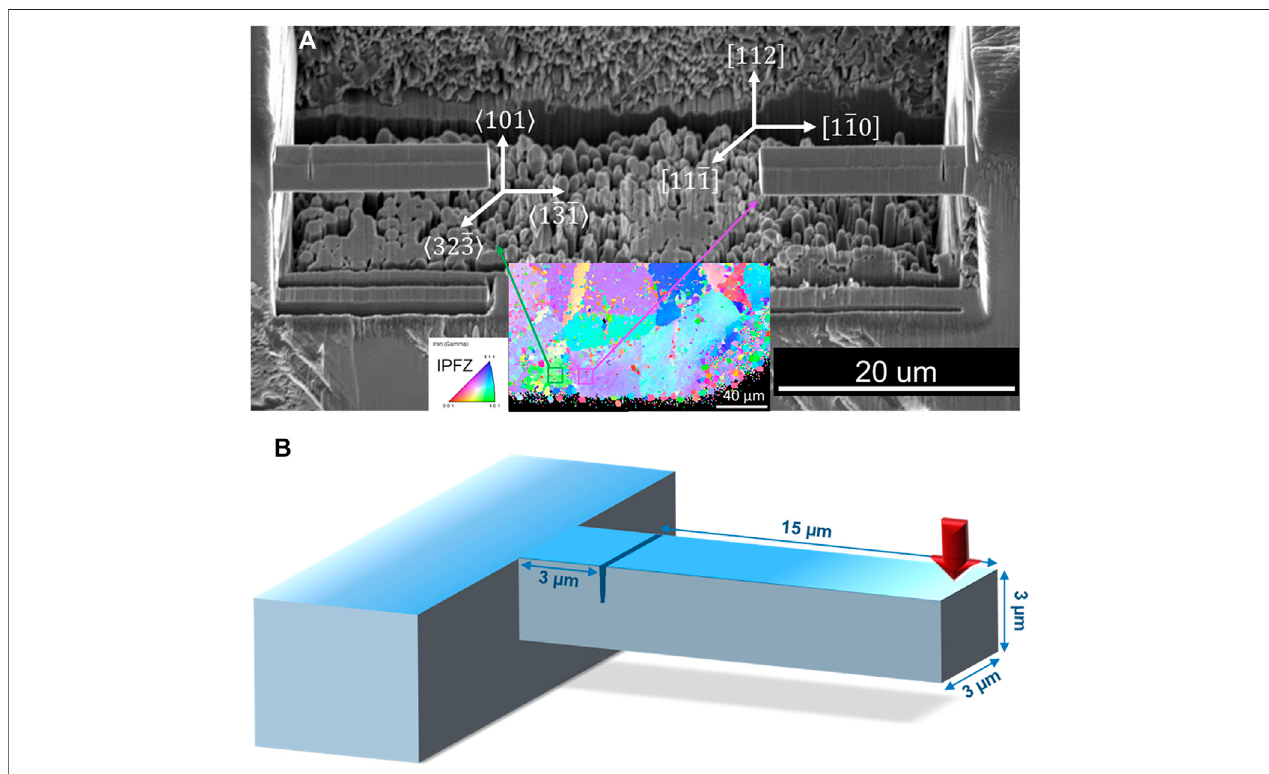
FIGURE 1 | (A) Fabricated microcantilevers in the archive material. The left cantilever is single crystalline with respect to bending direction < 101 > and the right cantilever is oriented towards < 112 > (IPFZ). (B) Schematic diagram of the dimensions of each microcantilever.